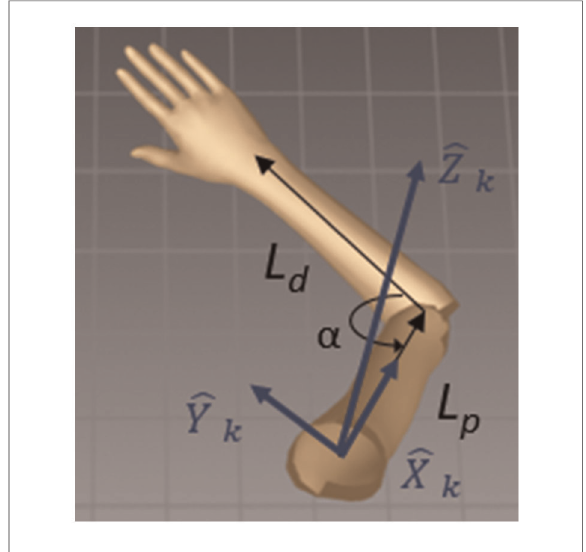
FIGURE 1 Shoulder coordinate frame. L d is the distal link. L p is the proximal link. ^ y ^ z ^ x k , k , and k are the shoulder coordinate frame axes. extension angle (the triangle angle).